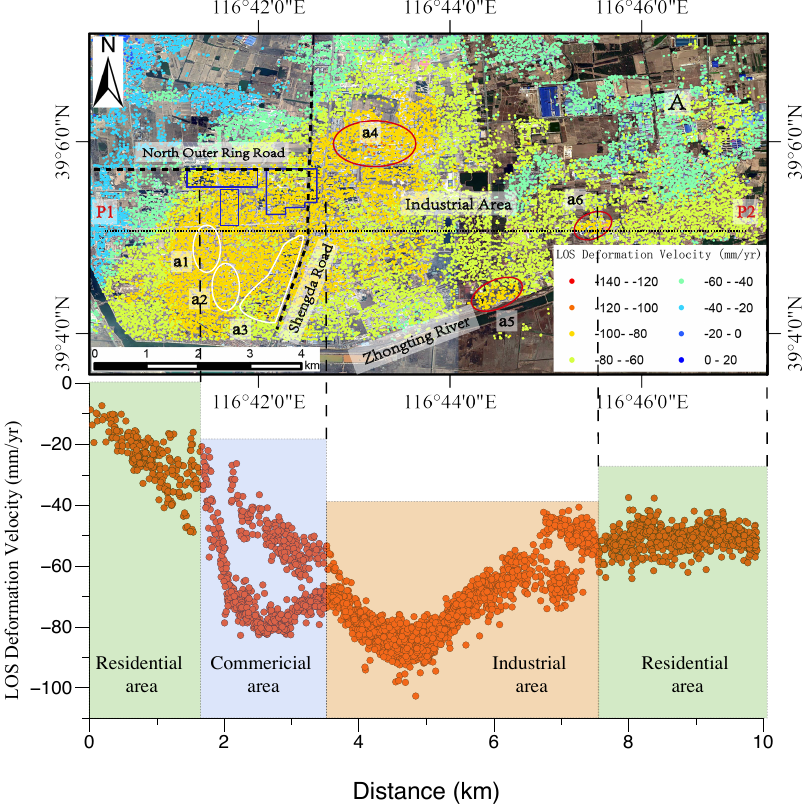
Figure 14. The mean LOS deformation velocity map over Shengfang Town, Part A, as shown in Figure 13. Zones a1, a2, and a3 represent commercial zones in Shengfang. The red ellipses indicate Zones a4, a5, and a6 where subsidence velocities are different from those in the surrounding areas and where there are many steel factories. The blue line represents the new residential district. The black dotted line from point P1 to P2 is the profile of Shengfang